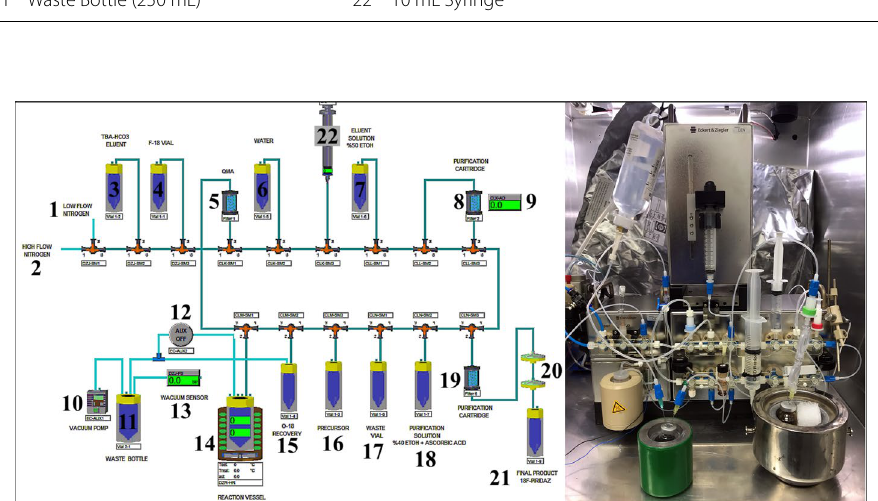
Fig. 5 Schematic HMI diagram of the automated synthesis of [ 18 F]Flurpiridaz ( 7 ). And the photo of the cassette, reagents, and ML PT